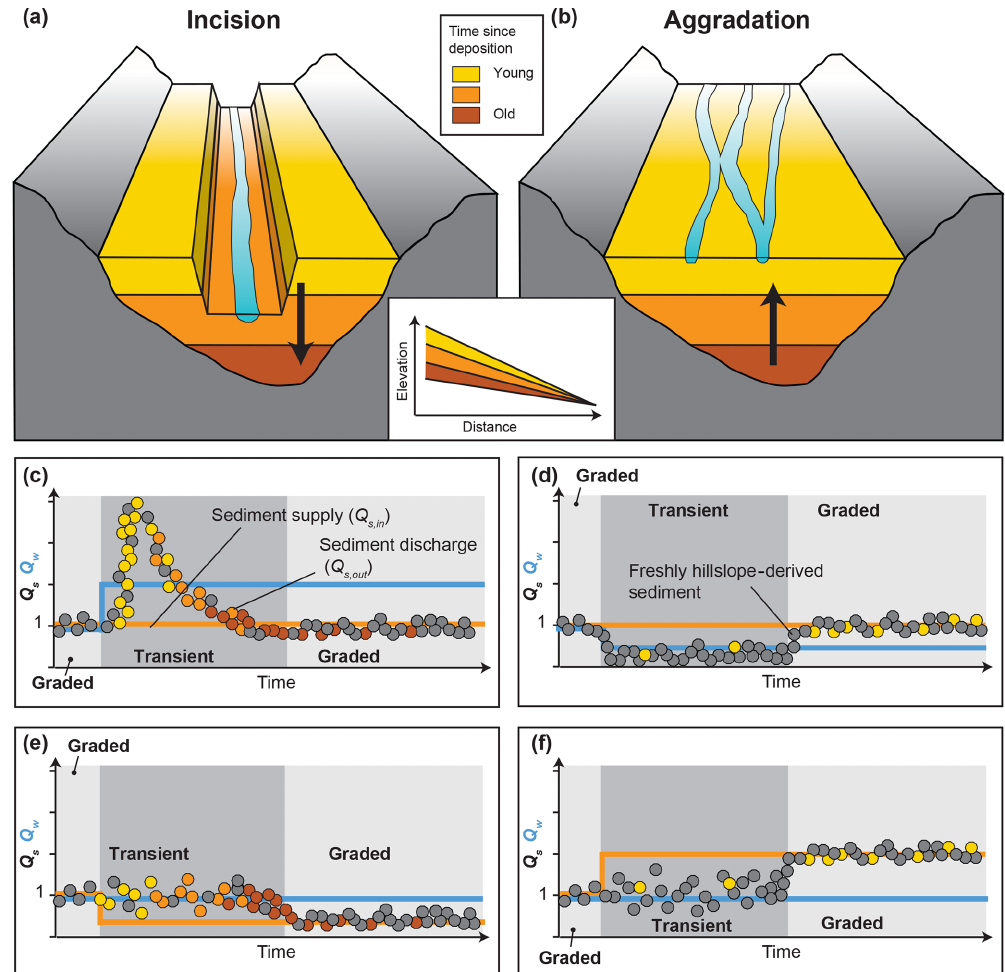
Figure 8. Schematic model of the evolution of Q s , out including inferred ages of the sediment. (a, b) Channel geometry and approximate distribution of sediment deposition ages during phases of incision and aggradation. (c–f) Evolution of Q s , out (circles) compared to Q s , in (orange solid line) and Q w (blue solid line) during the transient response phase after perturbation (dark grey), as well as after channel adjustment (light grey). The colors of the circles indicate the age (i.e., storage times before export) of the discharged sediment according to the panels (a) and (b)